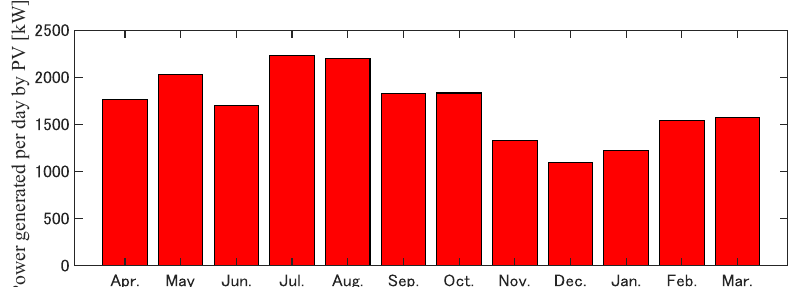
Figure 2. Daily generation of PV with a rated output of 500 kW by month.